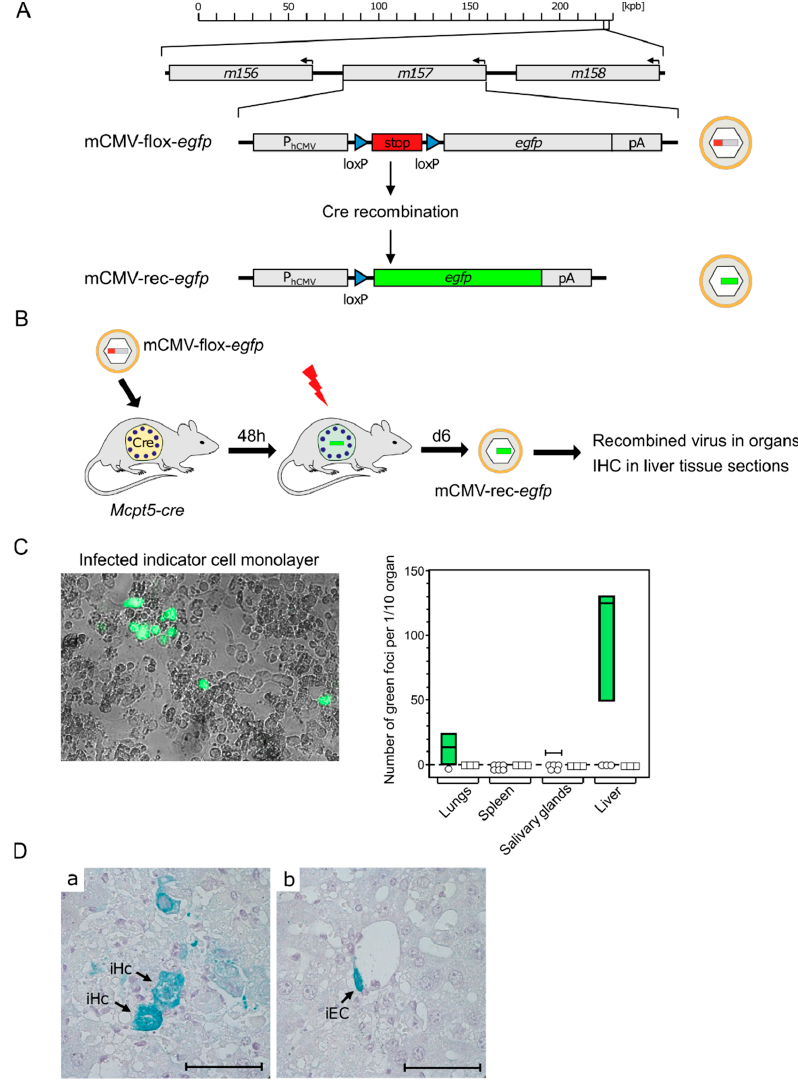
Figure 3. Evidence for productive mCMV infection of MC in vivo. ( A ) Gene maps explaining the principle of Cre recombination for generating reporter virus mCMV-rec- egfp . (kbp) Kilobase pairs of the linear, double-stranded DNA genome of mCMV. It circularizes in the infected cell and does not integrate into the cellular genome. The genomic region of interest is shown in detail. Arrows indicate the direction of transcription. (P hCMV ) hCMV promoter–enhancer; (pA) polyadenylation. ( B ) Experimental protocol. Mcpt5-cre mice were infected intraperitoneally with virus mCMV-flox- egfp . (Flash symbol) Total-body γ -irradiation with a dose of 7 Gy for immunosuppression to facilitate in vivo spread of recombined virus mCMV-rec- egfp . ( C ) Infection of mouse embryo fibroblast (MEF) monolayer cultures by homogenates of the indicated organs taken on day eight after infection. (Left) eGFP fluorescence and phase-contrast microscopy image showing green-fluorescent MEF infected with MC-derived mCMV-rec- egfp . (Right) Quantitation of green foci of MEF infected with MC- derived mCMV-rec- egfp . Green bars represent range, with median values marked, of data only from individual mice in which recombination has occurred to yield green-fluorescent MEF. Open symbols indicate mice in which recombinations were not detected in the respective organ. ( D ) Detection of infected cells in liver tissue sections taken on day eight after infection. Cells expressing MC- derived mCMV-rec- egfp were stained in turquoise color by immunohistochemistry (IHC) specific for eGFP. Light hematoxylin counterstain. The bar marker represents 50 µ m. Image: ( a ) iHc, infected hepatocytes; and ( b ) iEC, infected vascular endothelial cell. Results are displayed schematically and in a new arrangement based on original data published in [80] ( C ) and in [81] ( D